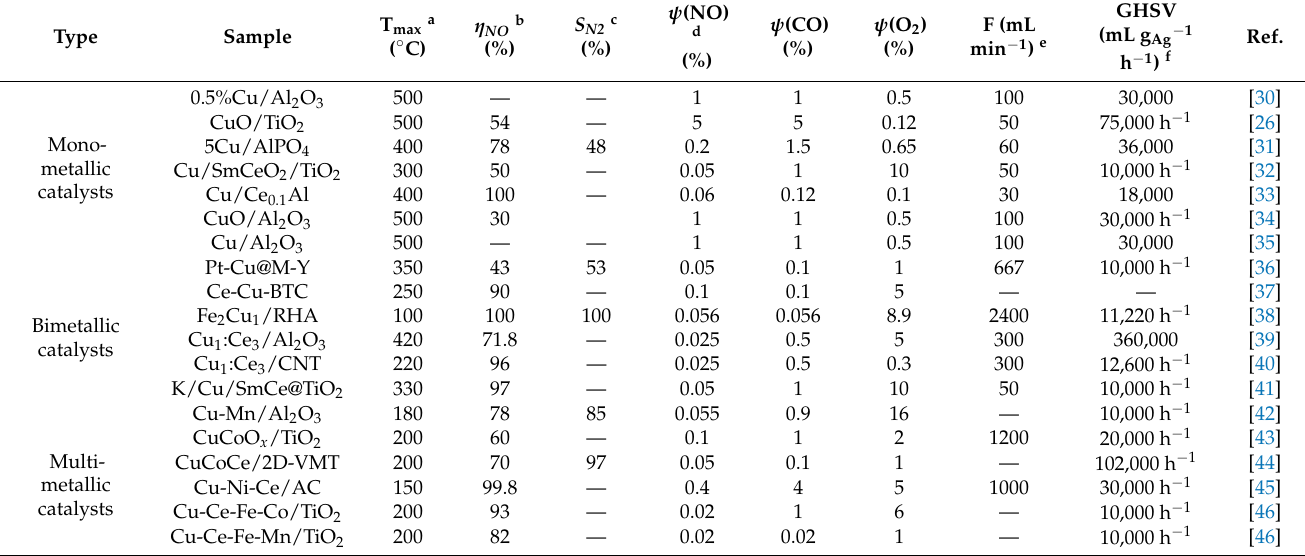
Table 1. Catalytic activity of various supported Cu-based catalysts for the NO + CO + O 2